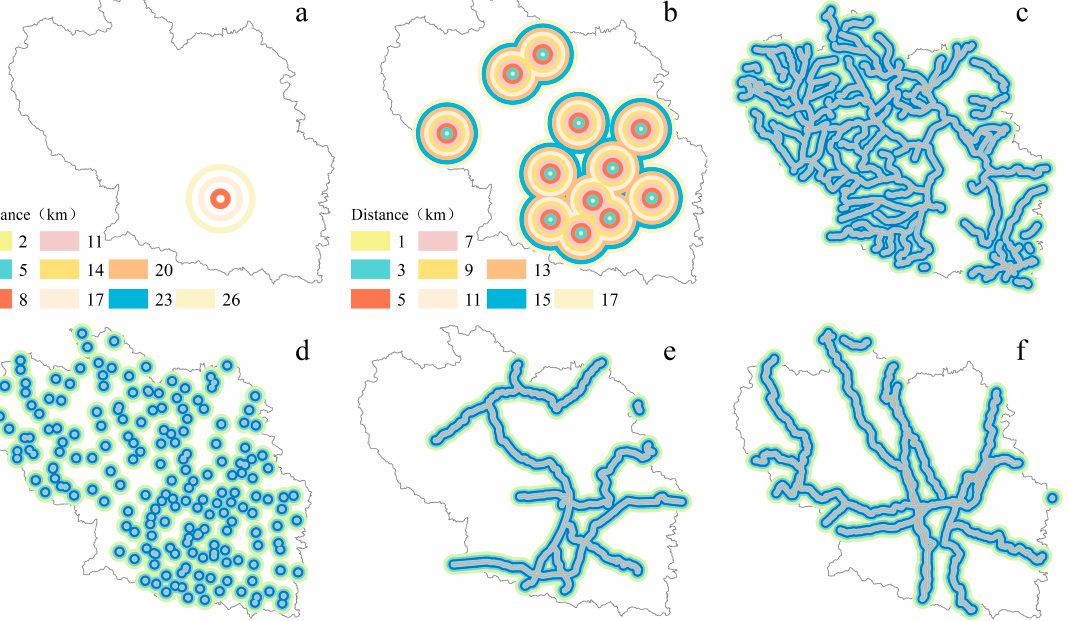
Figure 10. Map of urban spatial location buffer zone. ( a ) city center; ( b ) county center, ( c ) rivers, ( d ) settlements, ( e ) railways, ( f ) National roads, ( g ) provincial roads, ( h ) ex ‐ pressways, ( i ) county roads, ( j ) township roads, ( k ) reservoirs. The effect of different road grades on carbon stock density is shown in Figure 11. Higher ‐ level roads correlate more strongly with lower carbon den ‐ sity, and regional carbon stock density increases with increasing road dis ‐ tance. The data show that the carbon density within 200 m around the national road is the lowest at 91.70 t/ha, and within 200 m of the provincial road is 91.05 t/ha. The carbon density within 200 m of the township road, county road, and railway are 92.94 t/ha, 92.36 t/ha, and 92.73 t/ha. Expressway has the lowest carbon density within 200 m (96.22 t/ha), and provincial roads have a